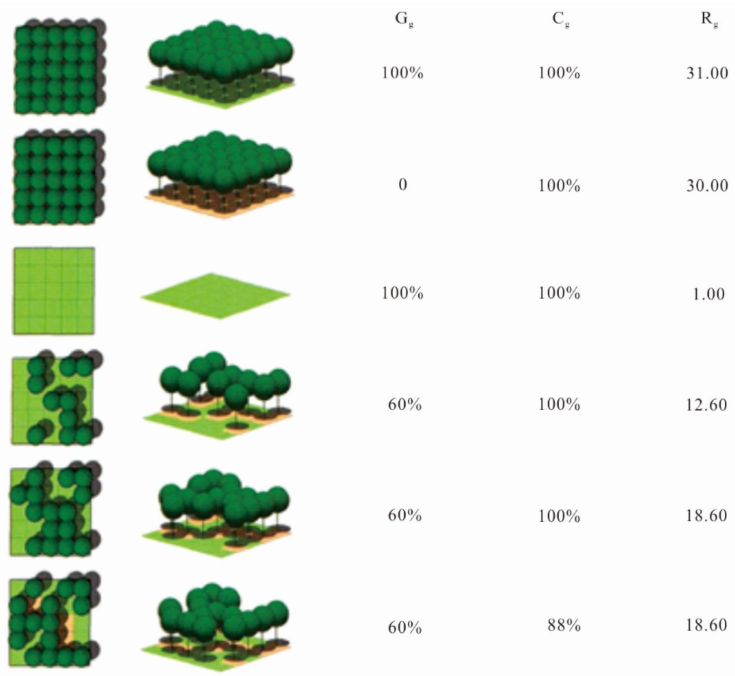
Figure 1. Green quantity indices for different green space configurations. G g : grass and shrub cover ratio; C g : green cover ratio; R g : ecological landscaping plot